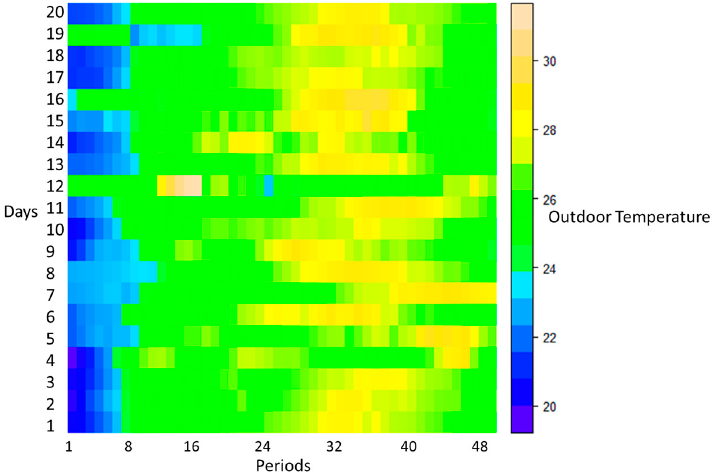
Figure 7. Outdoor temperature in each period for 20 days.